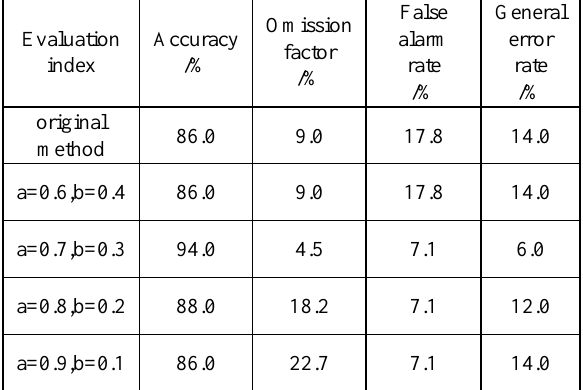
Table 5. The precision evaluation of different weights allocation change detection